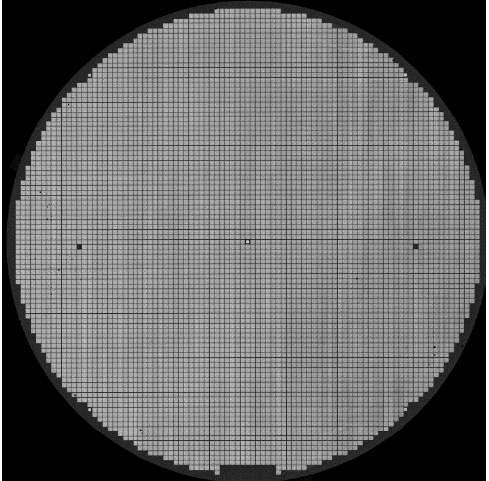
Figure 1. Original scanning acoustic tomography (SAT) image: example